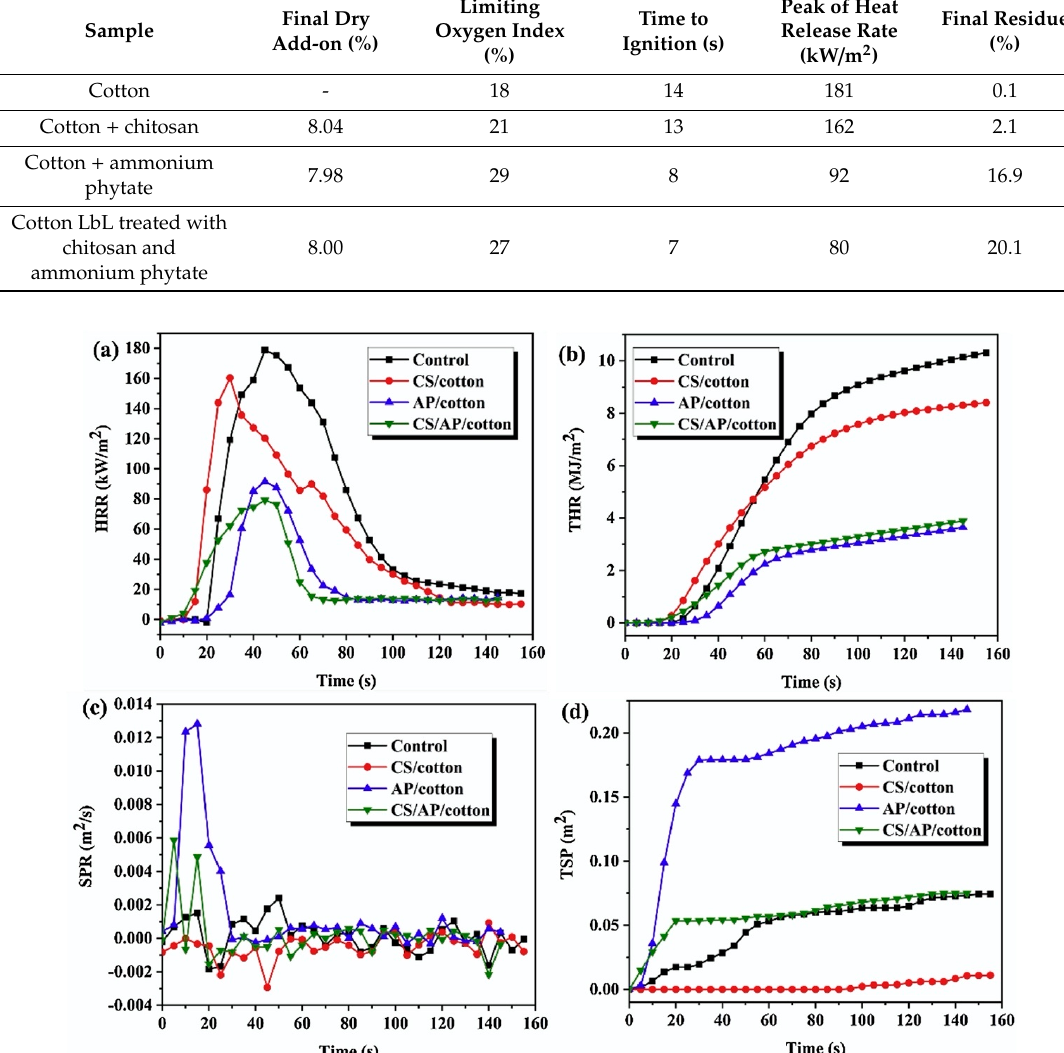
Table 3. Flame retardant behavior of untreated cotton and the treated fabrics.